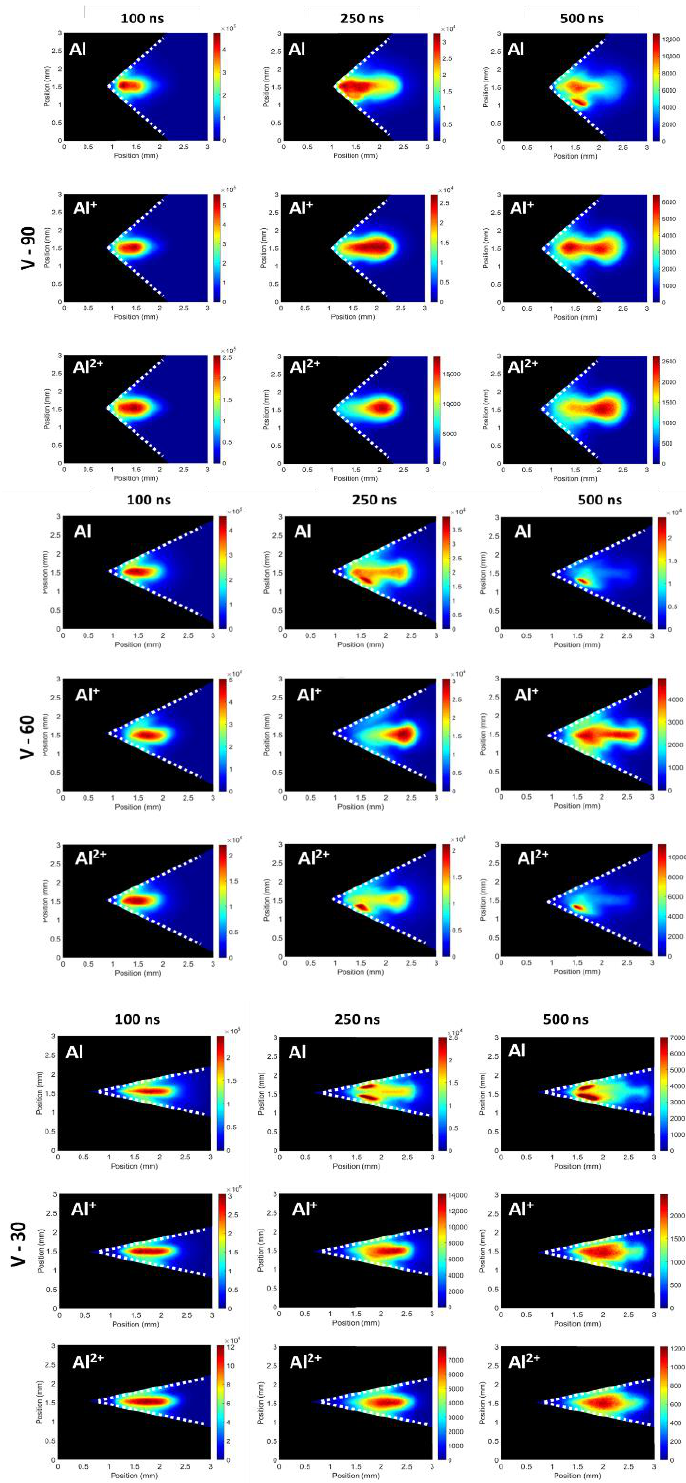
Figure 7. Spectrally filtered images of the 90°, 60° and 30° V-channel targets showing the different distributions of the Al, Al + and Al 2+ species at different time delays.